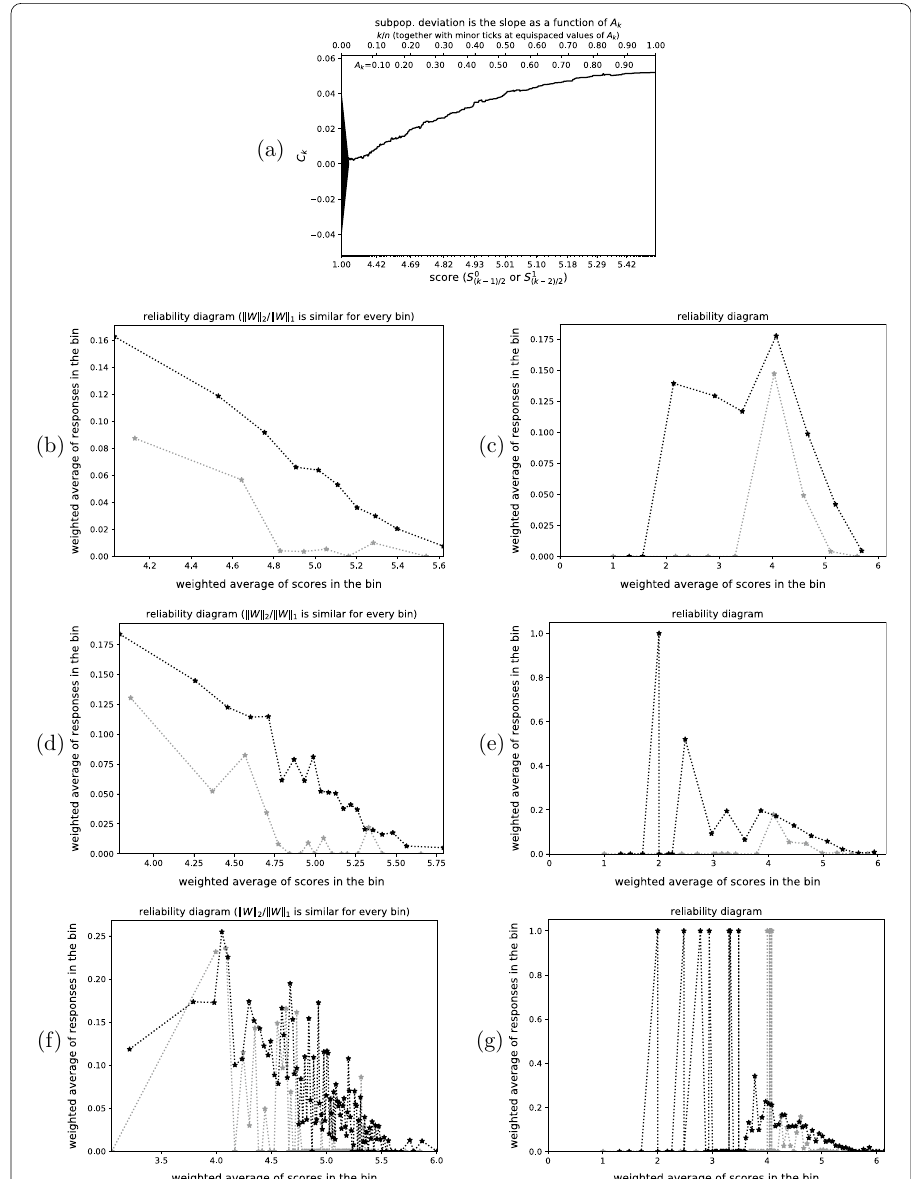
Fig. 10 Alameda County vs. Placer County; n = 2536; Kuiper’s statistic is 0.05192 /σ = 2.450 , Kolmogorov’s and Smirnov’s is 0.05192 /σ = 2.450 ; the behavior for small scores is interesting, as the cumulative graph ( a ) shows a big spike at the very lowest scores and then a very flat part, and only the reliability diagrams with 100 bins ( f and g ) reflect those. Yet the latter reliability diagrams are very, very noisy for the other scores. The metrics of Kuiper and of Kolmogorov and Smirnov report mildly statistically significant deviation between the